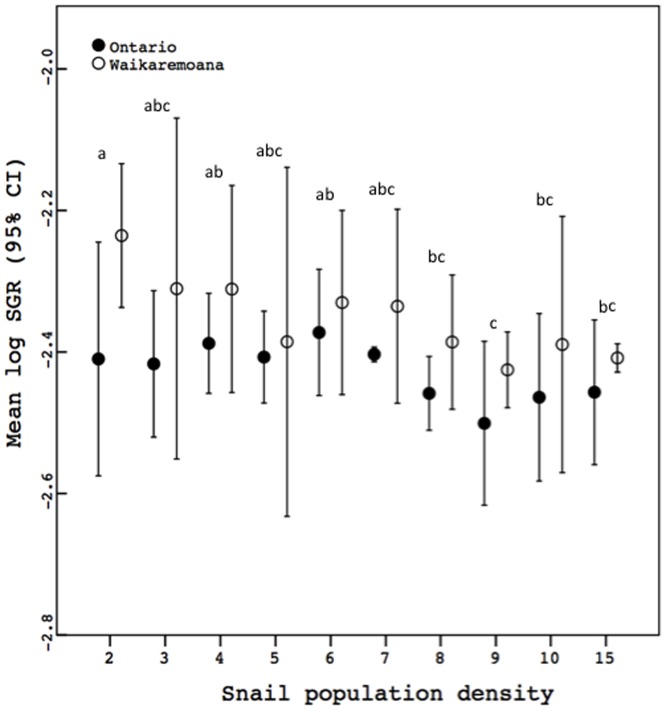
Mean log-transformed SGR per female across the ten population density treatments.Shared letters above error bars denote means (pooled across lineages; Tukey's honestly significant difference) that are not significantly different, while different letters indicate that p<0.05 for pairwise comparisons. p (a) = />0.309; p (b) = />0.171; p (c) = />0.051.